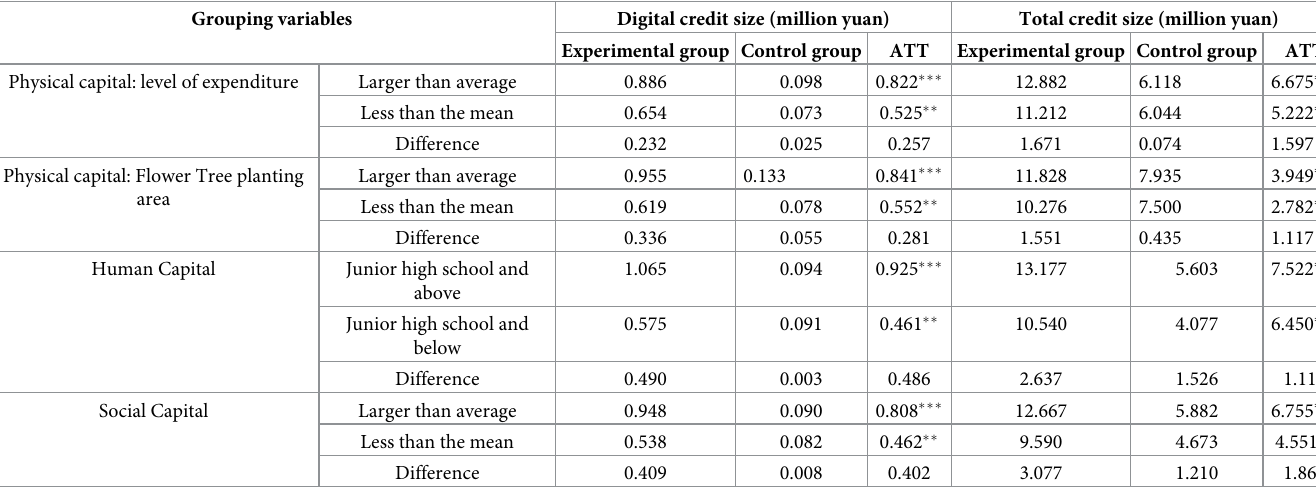
Table 9. Differences in the size of access to credit for e-commerce farmers with different endowment characteristics. Grouping